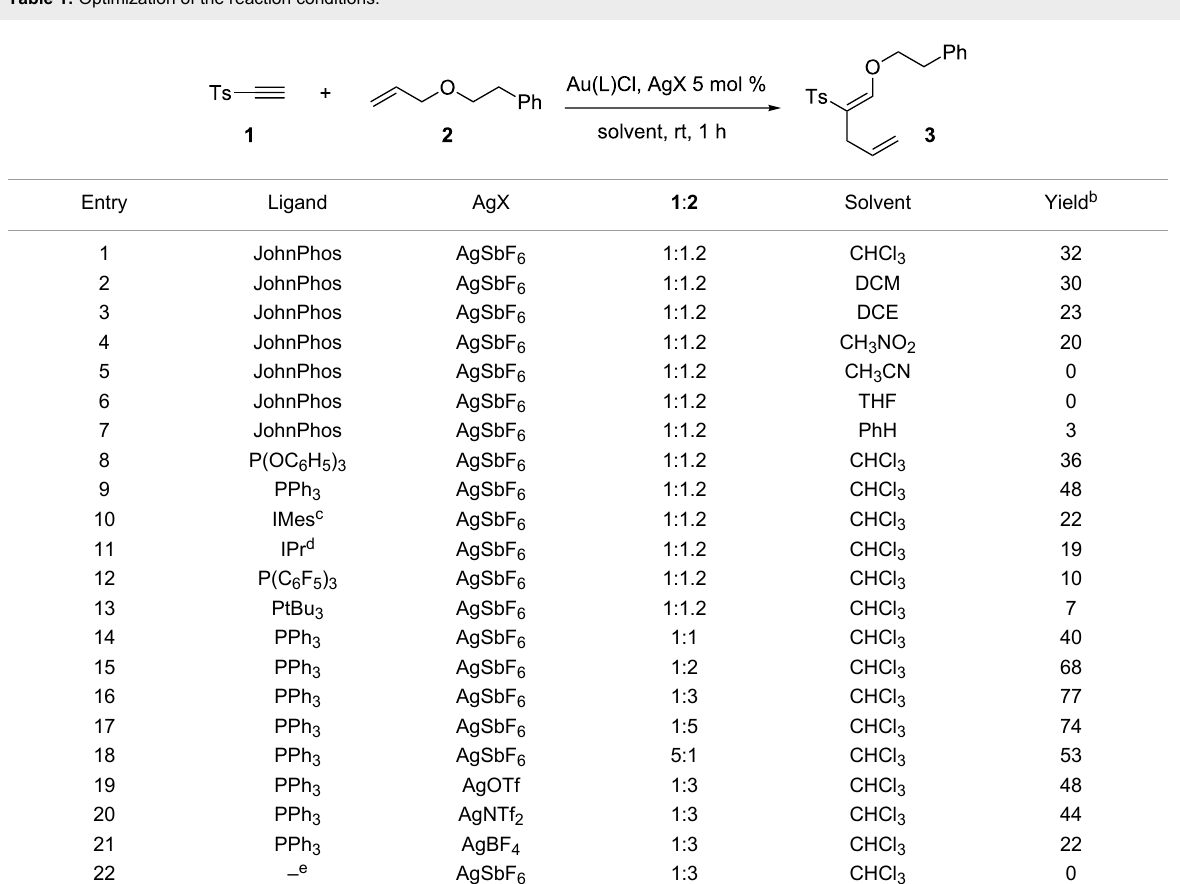
Table 1: Optimization of the reaction conditions. a